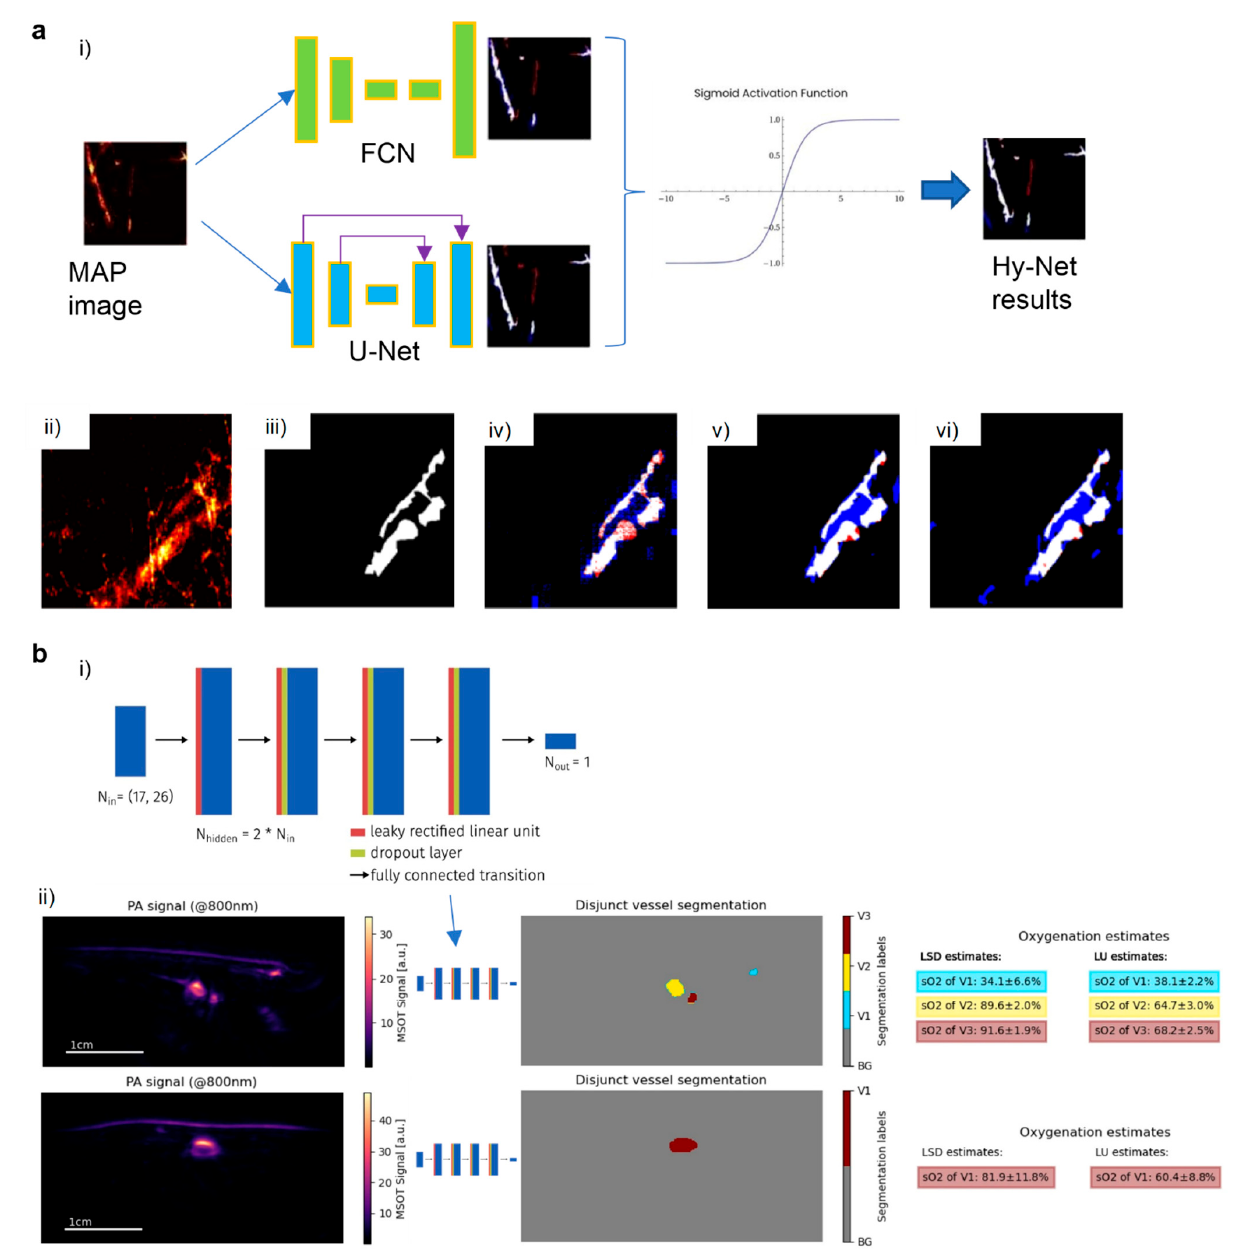
Figure 5. ( a ) (i) The structure of the Hy-Net-based concatenation of FCN and U-Net block followed by sigmoid activation; (ii–vi) visualization of segmentation: MAP images of sample, manual masks, FCN, U-Net, Hy-Net. Reproduced with permission from Yuan et al. [111]; published by OSA, 2020; ( b ) (i) visualization of the fully connected feed-forward neural network in LSD, (ii) Ii vivo results of LSD involving human forearms in B-scans and disjunct vessel segmentation. Reproduced with permission from Gröhl et al. [112]; published by Nature ,